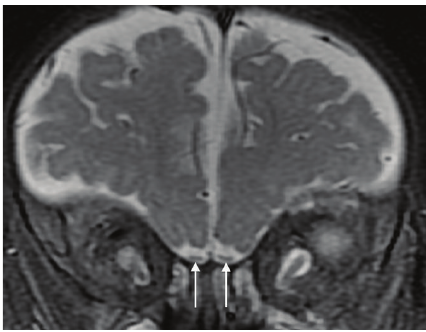
Figure 5: Coronal STIR (repetition time msec/echo time msec/in- version time msec, 4217/83/150) image demonstrating equivocal olfactory tract volume loss (arrows).